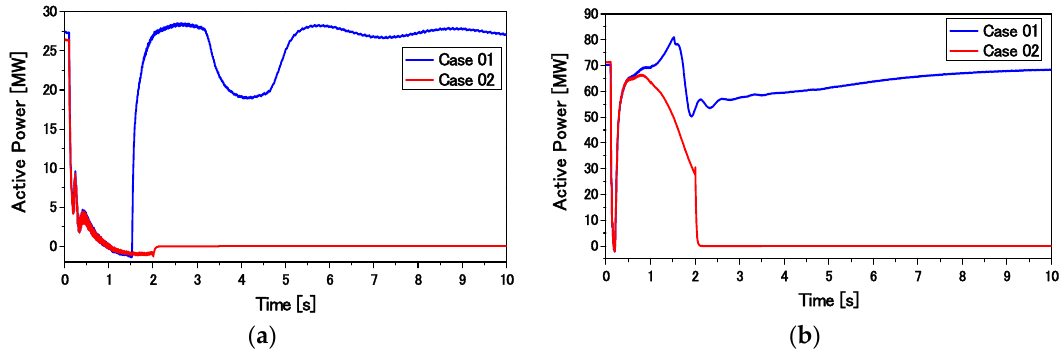
Figure 27. Active power output of wind generators: ( a ) DFIG; ( b ) SCIG.